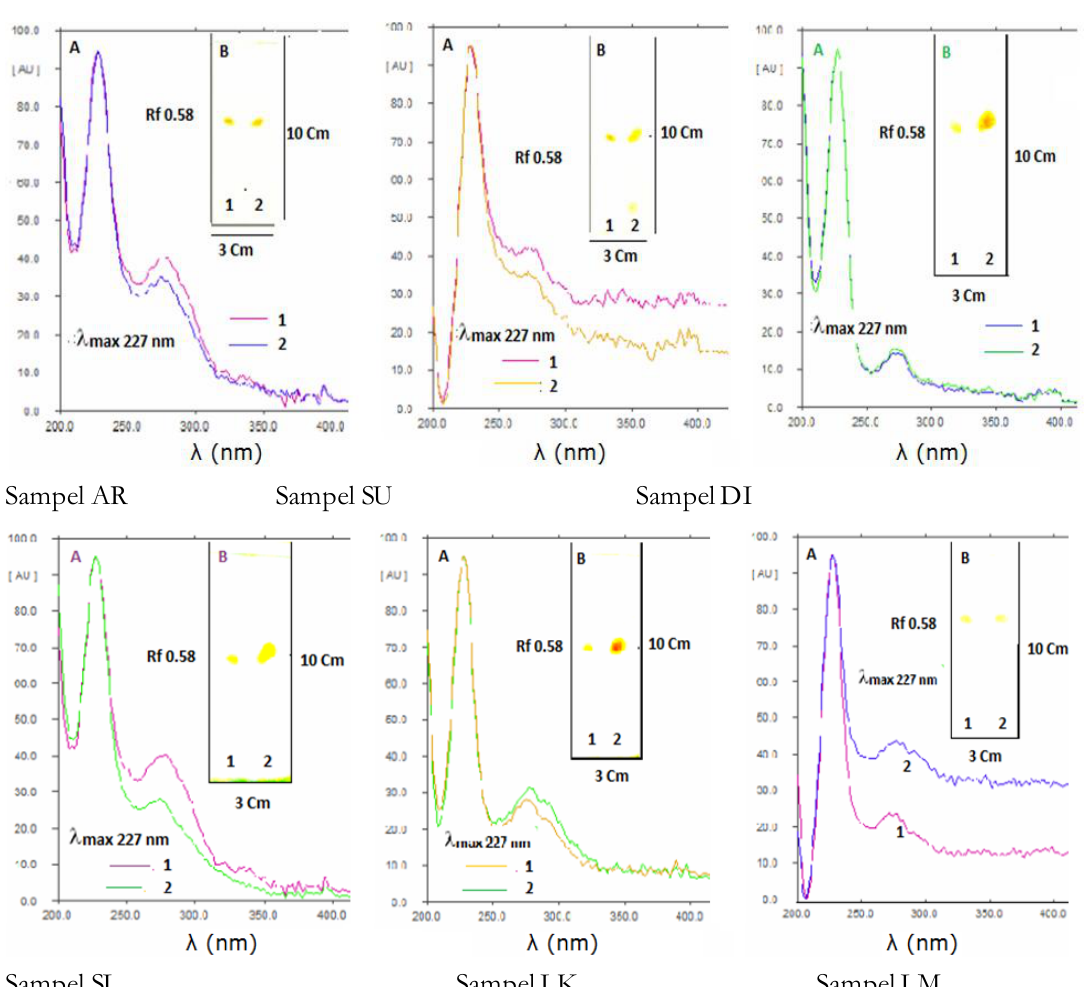
Figure 3. Calibration curve between peak area and concentration. Figure 4. UV spectrum of the chromatogram spot (A) and TLC chromatogram after spraying with Dragendorff